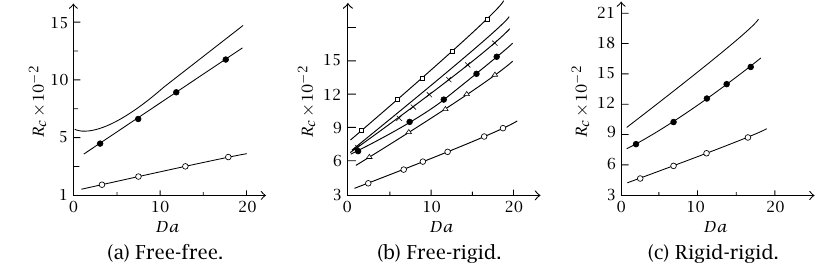
Figure 4.4 . Plot of Da versus R c for different basic-state temperature profiles with respect to velocity boundary combination. Parameter values: Λ = 0 . 9 , Q = 0 . 1, and Γ 1 = 0 . 1. (—) linear; ( • ) heating from below; ( ◦ ) step function; ( (cid:5) ) cooling from below; ( (cid:2) ) inverted parabolic; ( × ) parabolic.